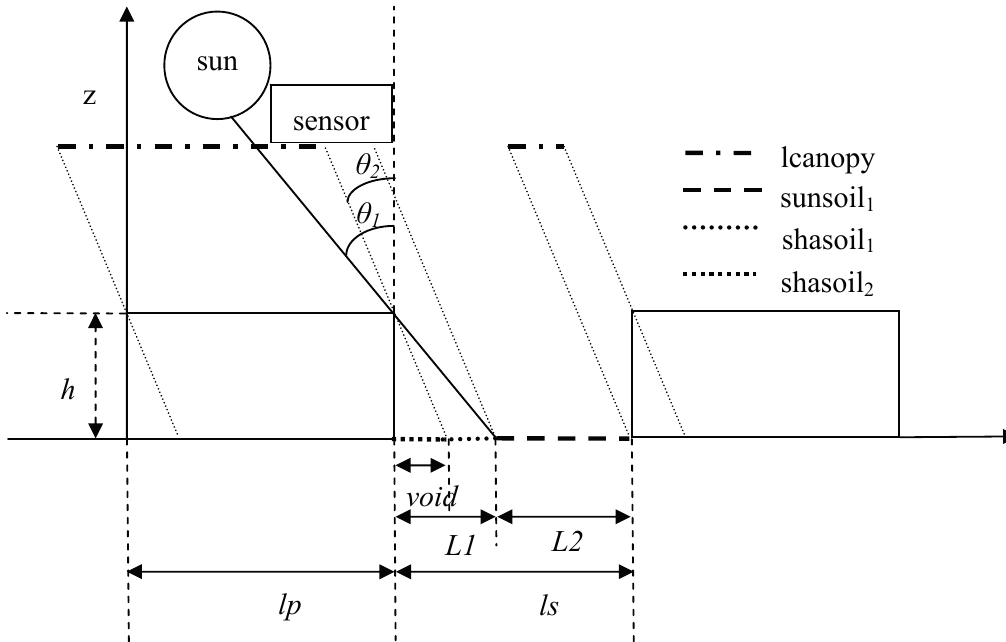
Figure 5. The sketch map of the forward-scatter